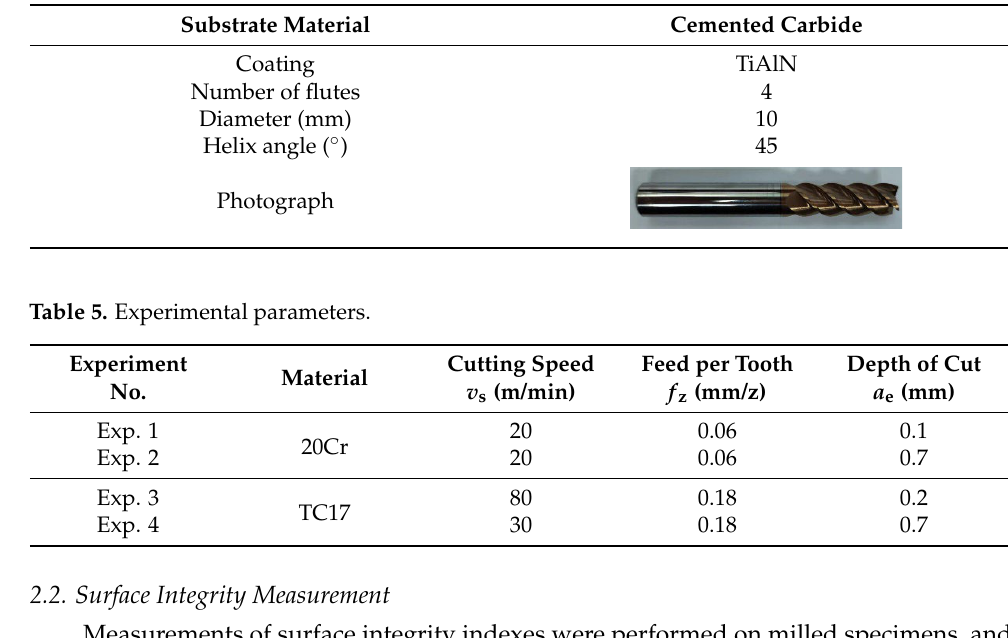
Table 4. Cutter conditions.